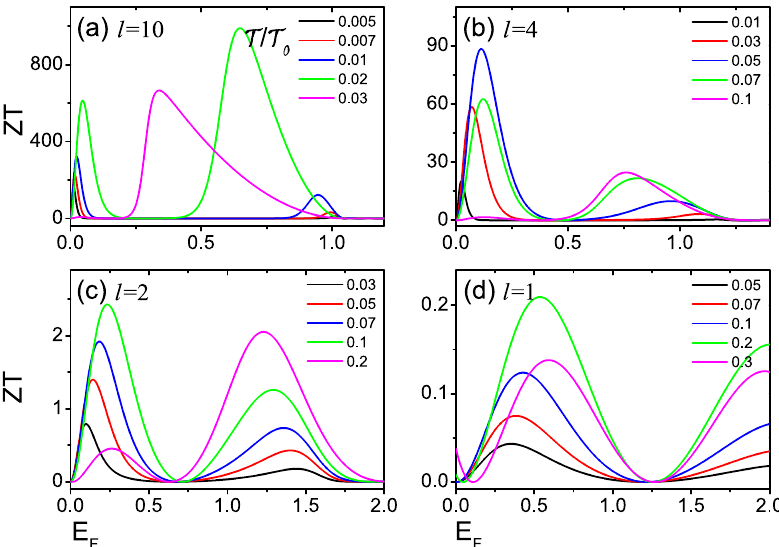
Figure 6. The thermoelectric figure of merit ZT as functions of Fermi energy E F for different temperatures T π . Two magnetic domains of equal size l = 10 in ( a ), and l = 4 in ( b ), and l = 2 in ( c ) and / T 0 with relative tilt φ = l = 1 in ( d ). The other unmentioned parameters are the same as in Fig.